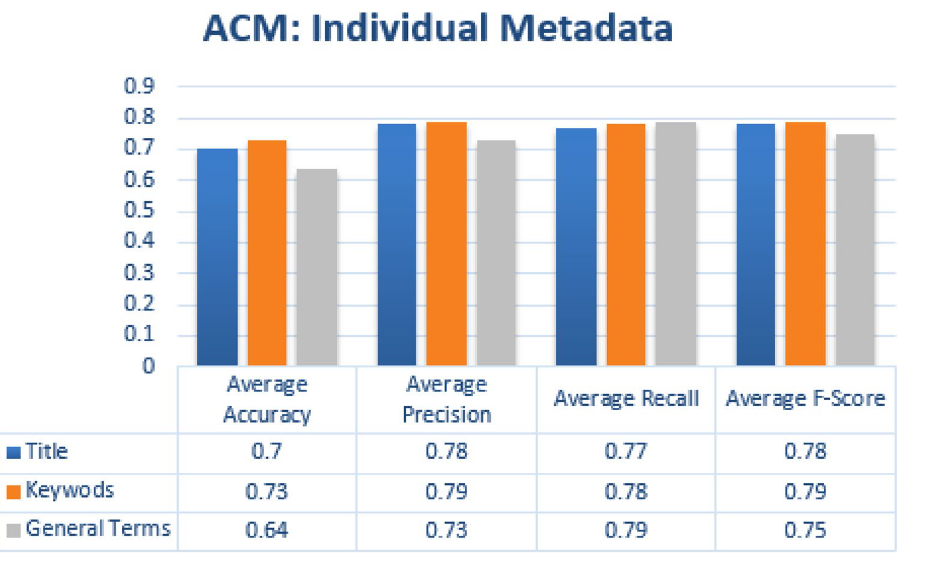
Figure 14. ACM (individual